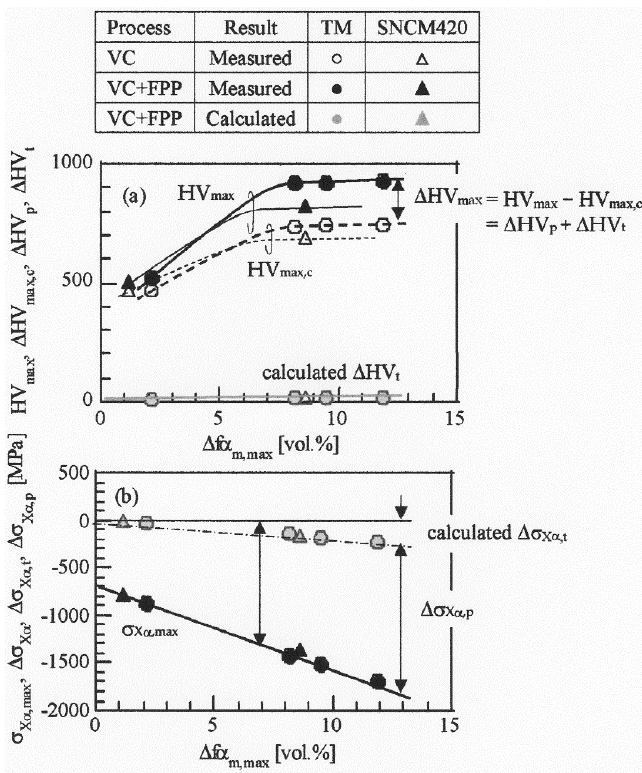
Figure 6. Relationships between ( a ) Vickers hardness and ( b ) residual stress properties and maximum volume fraction of strain ‐ induced martensite ( Δ f α m,max ) in TM ( ●● ○ ) and SNCM420 ( ▲▲ Δ ) steels. HV max : Maximum hardness after vacuum ‐ carburization and fine ‐ particle peening (VC + FPP); HV max,c : Maximum hardness after vacuum ‐ carburization (VC); Δ HV max , Δ HV p and Δ HV t : Increments of hardness due to fine ‐ particle peening, the severe plastic deformation and the strain ‐ induced martensitic transformation, respectively; X α ,max : Maximum compressive residual stress after vacuum carburization and fine ‐ particle peening; Δ σ X α ,max , Δ σ X α ,p , and Δ σ X α ,t : Increments in σ X α ,max due to fine ‐ particle peening, calculated compressive residual stresses due to the severe plastic deformation and estimated compressive residual stress due to the strain ‐ induced martensitic transformation, respectively. Table 4. Estimated surface ‐ hardened layer properties of TM and SNCM420 steels subjected to vacuum ‐ carburization under various carbon potentials and subsequent fine ‐ particle peening.